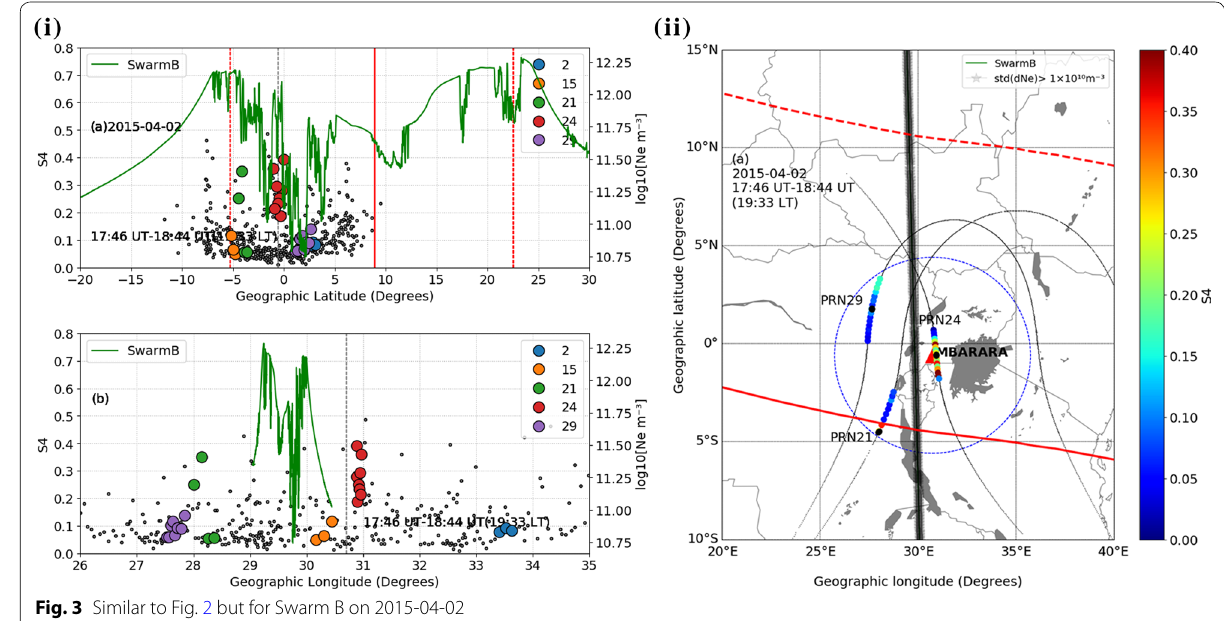
Fig. 3 Similar to Fig. 2 but for Swarm B on 2015-04-02